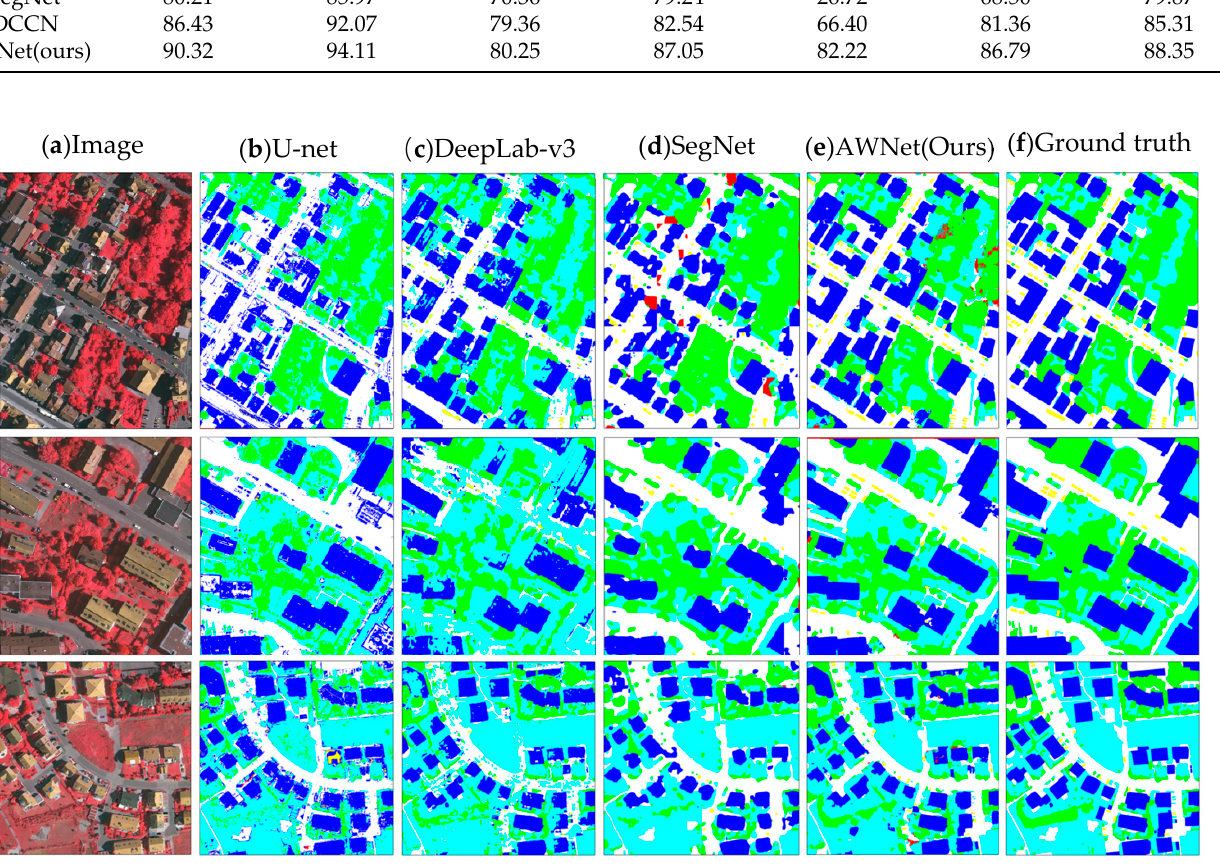
Figure 10. The output image of our network compared with the classic network. Vaihingen’s label includes six categories: impervious surface (white), building (blue), low vegetation (cyan), tree (green), car (yellow), and chaos/background (red). ( a ) Input image. ( b ) U-net segmentation results. ( c ) Segmentation result of DeepLab-v3. ( d ) The segmentation result of SegNet. ( e ) We propose the segmentation result of AWNet. ( f ) Ground Truth.